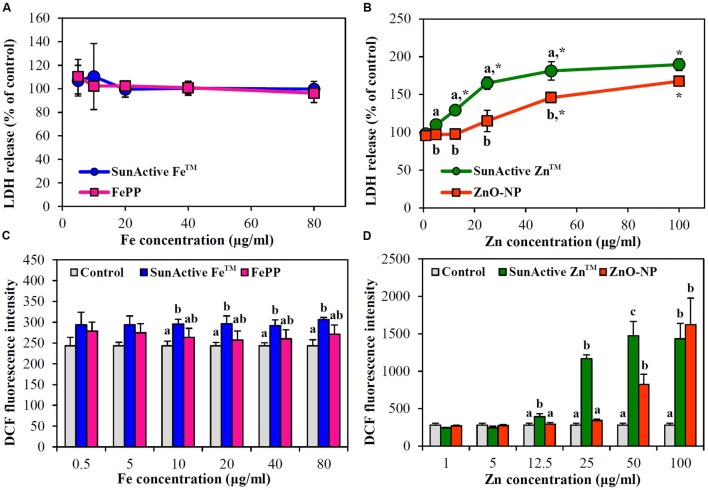
Effect of
(A,C) SunActive FeTM and (B,D) SunActive ZnTM on (A,B) LDH release and (C,D) ROS generation in INT-407 cells after treatment for 24 h. FePP and ZnO-NPs were used as counterpart materials for SunActive FeTM and SunActive ZnTM, respectively. Mean values with different letter (a,b,c) in the same concentrations indicate significant differences among untreated control, SunActiveTM product, and its counterpart material (p < 0.05). ∗ Indicates significant differences from the untreated controls (p < 0.05).